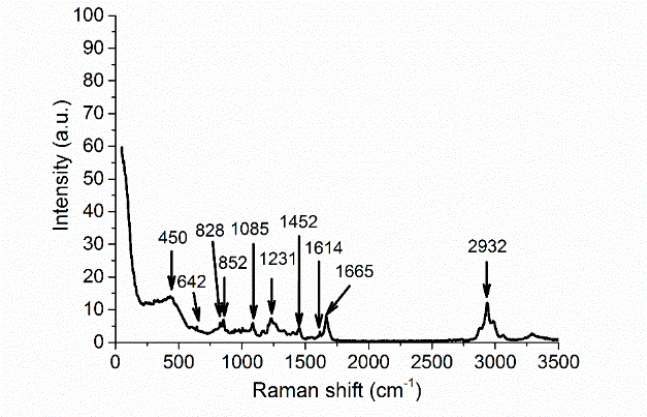
Figure 3. The Raman spectra of the silk sample deposited on a silica-on-silicon substrate (silk #1).